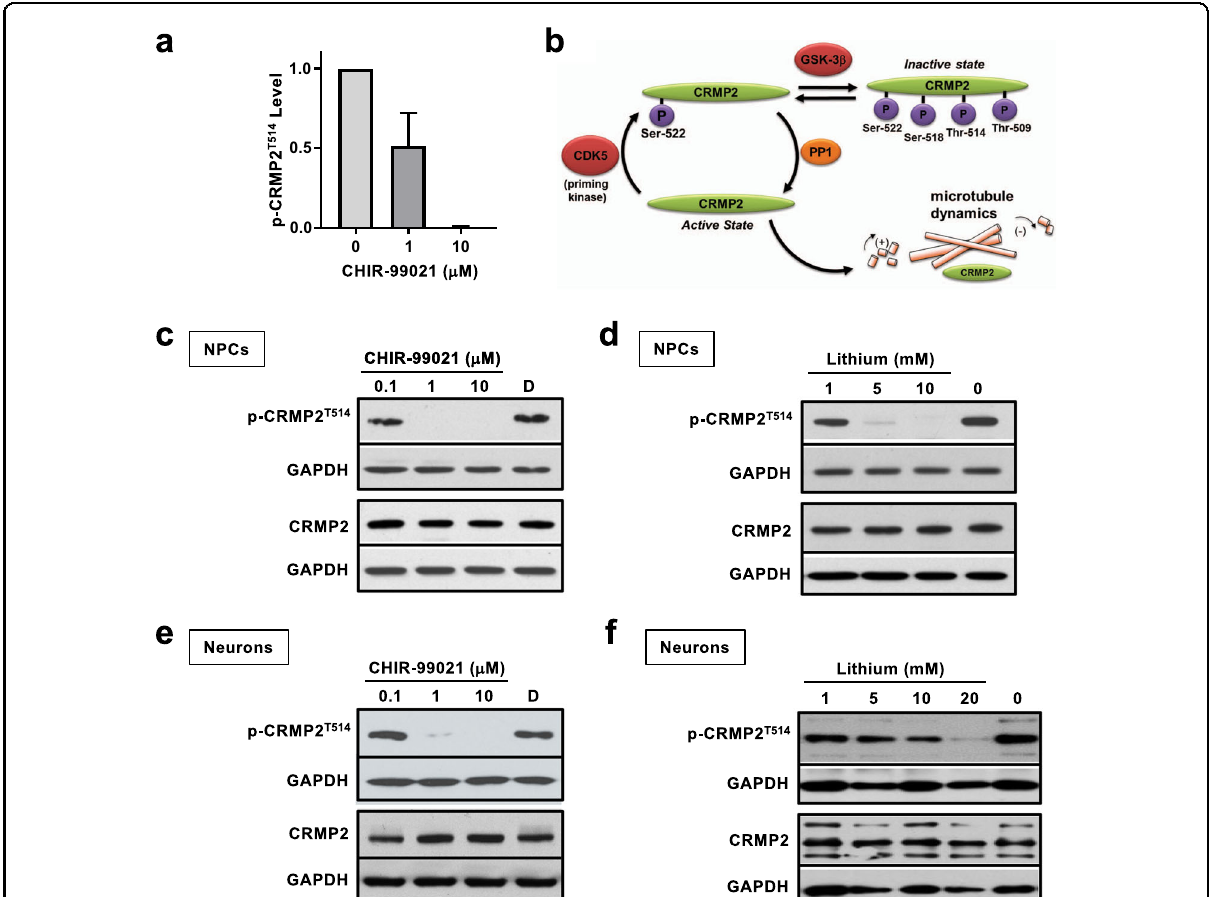
Fig. 2 Reduced phosphorylation of CRMP2 at Thr514 upon treatment with CHIR-99021 and lithium. a CRMP2 was identi fi ed with reduced phosphorylation at Thr514 as previously reported in Tobe et al. 15 . A bar graph of CRMP2 T514 phosphopeptide ratios in CHIR-99021-treated over control is shown. The UniProt gene symbol for CRMP2 is DPYSL2. b Schematic of key phosphorylation events on CRMP2 involving CDK5 and GSK3 β . CDK5 phosphorylates CRMP2 at Ser522, providing a primed substrate for subsequent phosphorylation by GSK3 at Ser518, Thr514, and Thr509. Phosphorylation of CRMP2 at Thr514 has been shown to be GSK3 β -speci fi c. The phosphorylation events are essential for diverse CRMP2 cellular functions. c Western blot analysis validated that p-CRMP2 T514 levels were decreased after 6-h treatment of NPCs with CHIR-99021 in a dose- dependent manner. Total CRMP2 protein was not affected by the treatments. d Lithium treatment in NPCs for 6 h effectively reduced p-CRMP2 T514 levels in a dose-dependent manner. e CHIR-99021 and f lithium also exhibited dose-dependent reduction of p-CRMP2 T514 on the 4-week differentiated neuronal cultures. Total CRMP2 protein was not affected by the